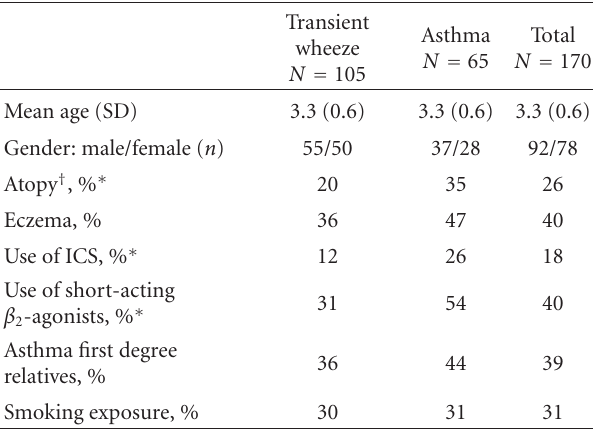
Table 1: Characteristics at baseline for transient wheezers and true